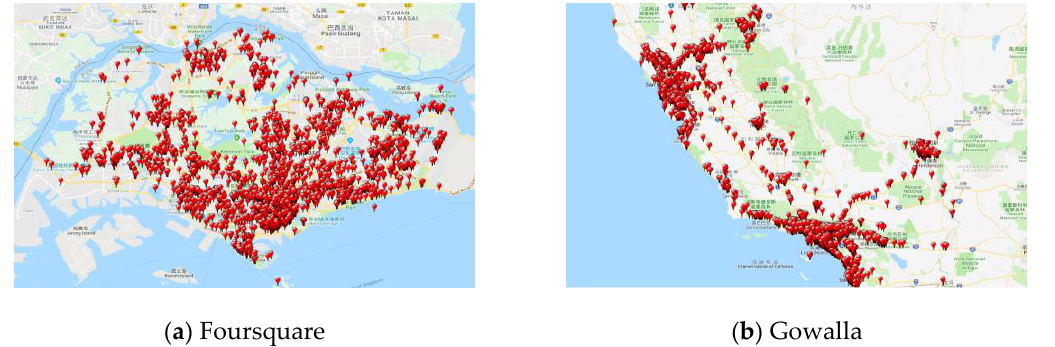
Figure 5. All users’ check-in distribution of POIs in the two datasets.